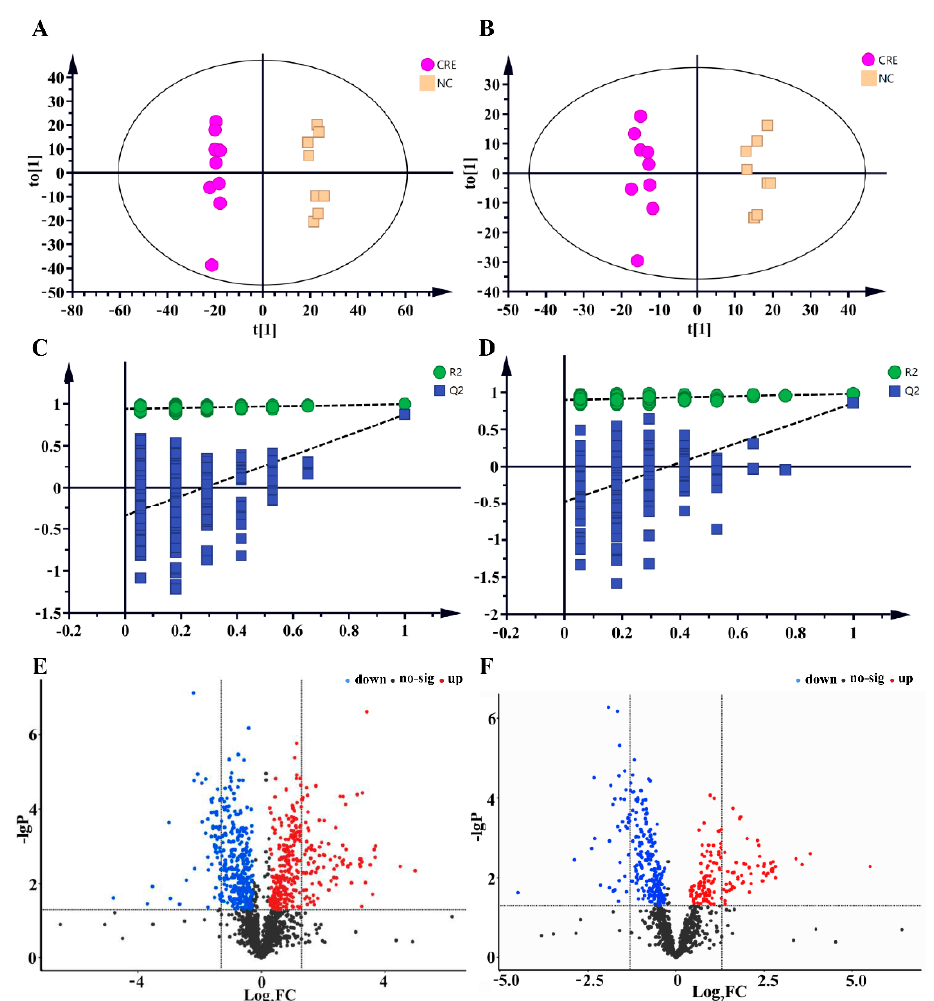
Figure 7. OPLS-DA score plot, permutation test and volcano plot for lipidomics in the positive ion ( A , C , E ) and negative ion modes ( B , D , F ). R2, explained variance; Q2, predictive ability of model. The red and blue dots in volcano plot represent the significantly up-regulated and down-regulated lipids species, respectively. FC, fold change.